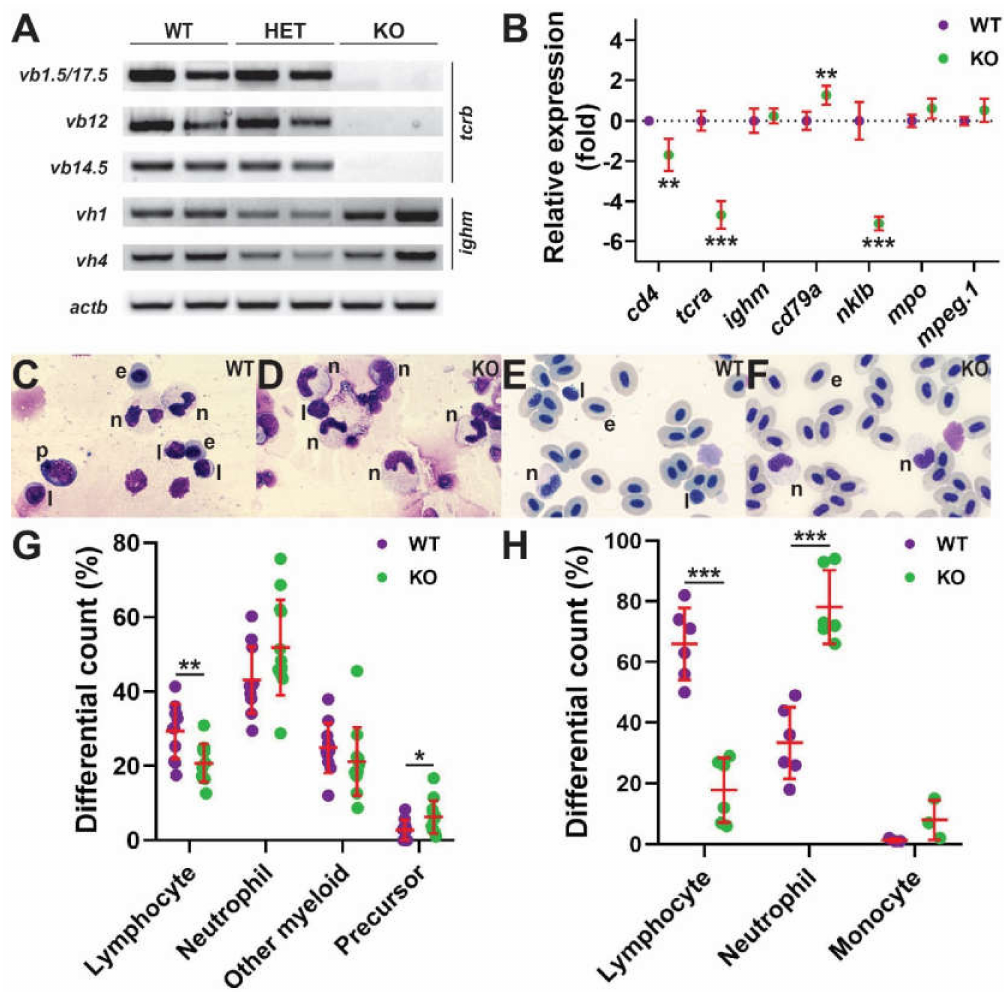
Figure 2. Effect of Il-2r γ c.a ablation on later hematopoiesis. ( A , B ) Gene expression analysis. Larvae (28 dpf) obtained from in-crossing il2rga wt/mdu2 heterozygotes were harvested for gDNA and total RNA. The gDNA was used for the identification of wild-type (WT), heterozygote (HET), and ho- mozygote knock-out (KO) siblings, and the RNA was subjected to RT-PCR with primers specific for T cell receptor β chain V(D)J-C β rearrangements ( tcrb : vb1.5 , vb12 , vb14.5 ), B cell immunoglobulin M heavy chain gene rearrangements ( ighm : vh1 , vh4 ), and β -actin ( actb ) as a control ( A ) RT-negative controls yielded no products (data not shown) ( n = 2). ( B ) Adult kidney derived total RNA was subjected to qRT 2 -PCR with gene markers of T cells ( cd4 , tcra ), B cells ( ighm , cd79a ), NK cells ( nklb ), neutrophils ( mpo ), and monocyte/macrophages ( mpeg1.1 ) ( B ) Data was normalized relative to actb and represented as relative fold change compared to wild-type fish, with mean and SD shown in red and statistical significance indicated (**: p < 0.01, ***: p < 0.001, n = 6). Histological analysis ( C – H) Representative images of Giemsa-stained kidney ( C , D ) and blood ( E , F ) cells were obtained from WT ( C , E ) and KO ( D , F ) fish. Abbreviations: e, erythrocyte; l, lymphocyte; n, neutrophil; p, precursor. Differential counts of kidney ( G ) and blood ( H ) cells, showing results for individual embryos, with mean and SD in red and statistical significance indicated (*: p < 0.05, **: p < 0.01, ***: p < 0.001, kidney: n = 11–12, blood: n =